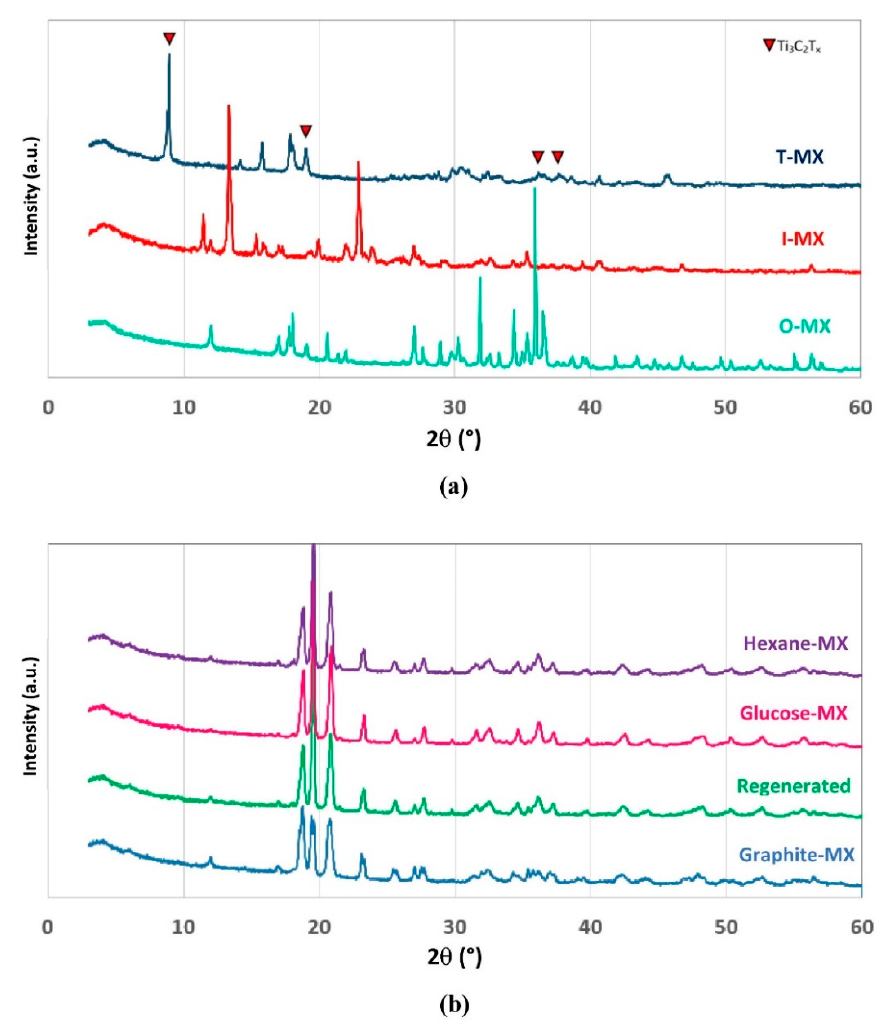
Figure 4. Di ff ractograms of ( a ) MXene-based adsorbents materials with di ff erent ligands, and ( b ) Figure 4. Diffractograms of ( a ) MXene ‐ based adsorbents materials with different ligands, and ( b ) of MXene prepared with graphite, spent T ‐ MX (after methylene blue adsorption) and different